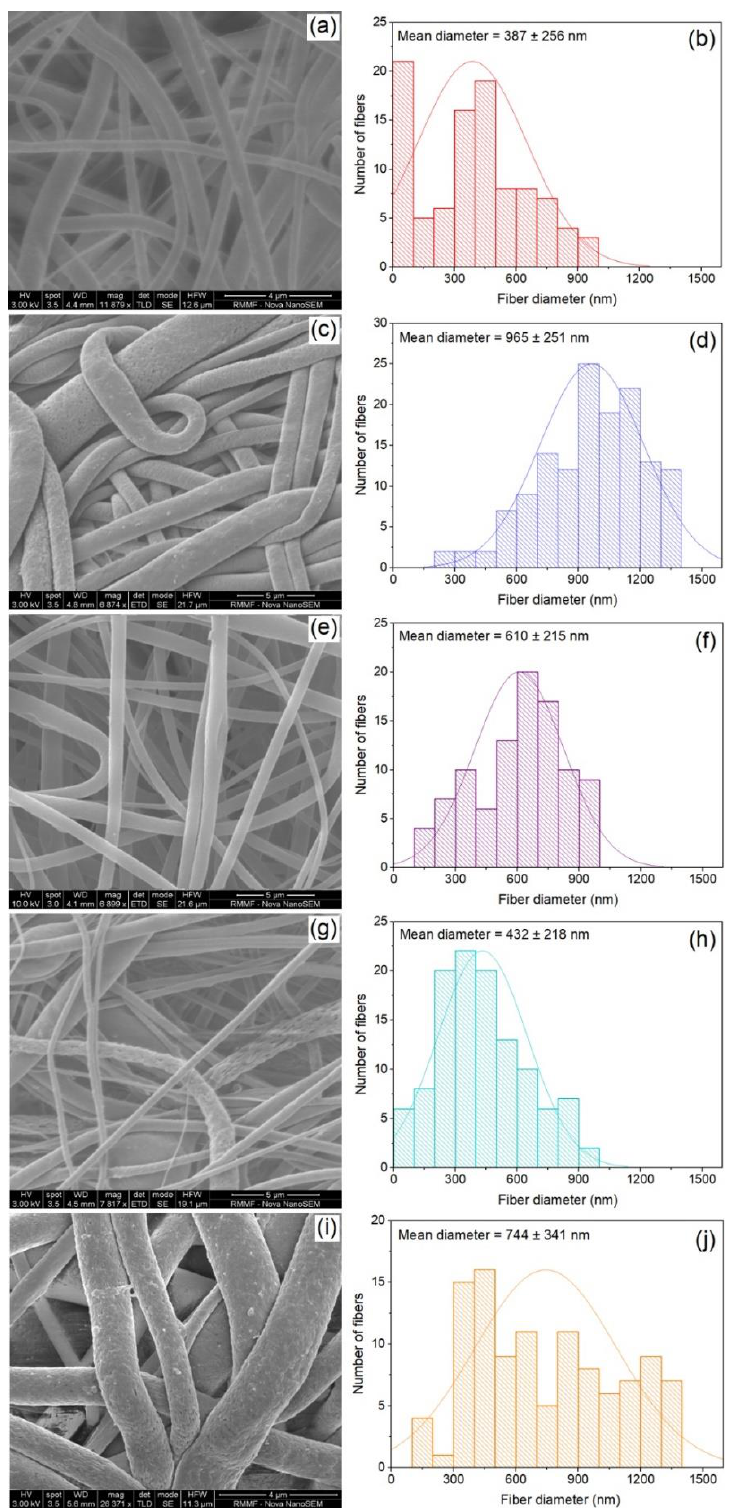
Figure 2. SEM images and fiber diameter distribution of fabricated membranes: ( a , b ) P, ( c , d ) GP-1, ( e , f ) GP-2, ( g , h ) ZP-1, and ( i , j ) ZP-2. ( e , f ) GP-2, ( g , h ) ZP-1, and ( i , j )